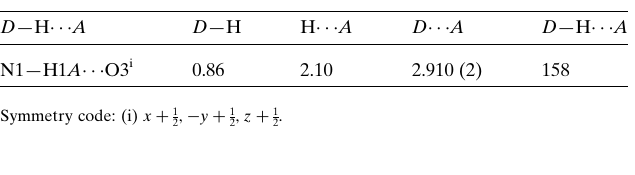
Table 2 Experimental details.